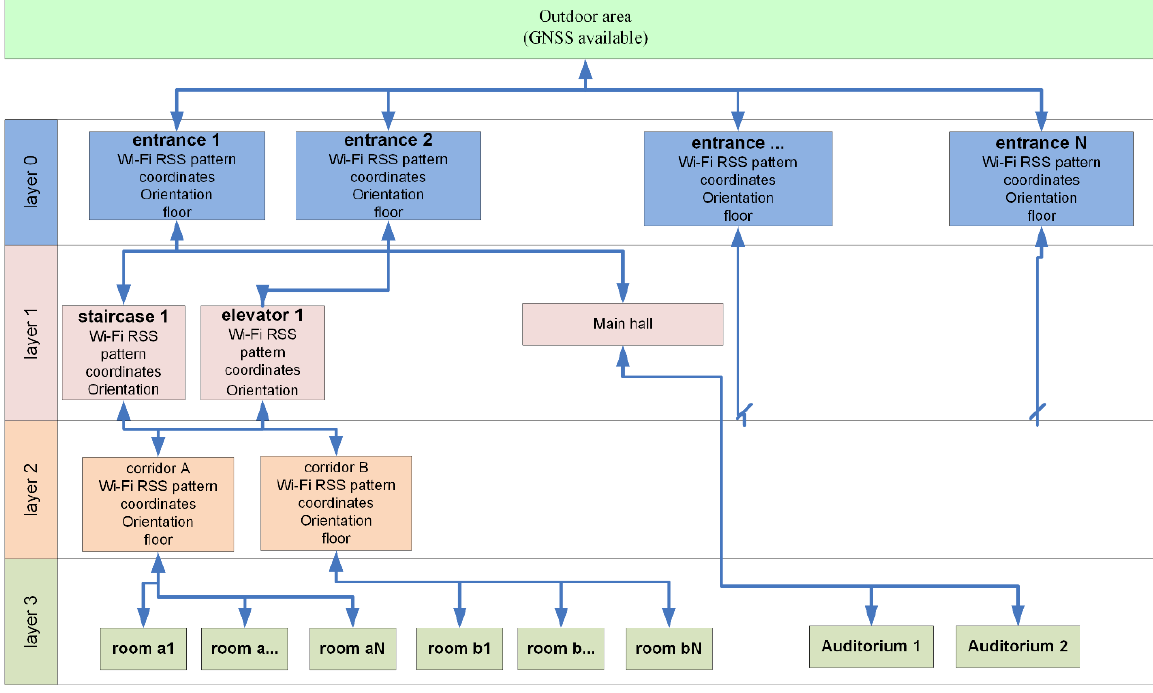
Figure 1. Layers and model of a possible